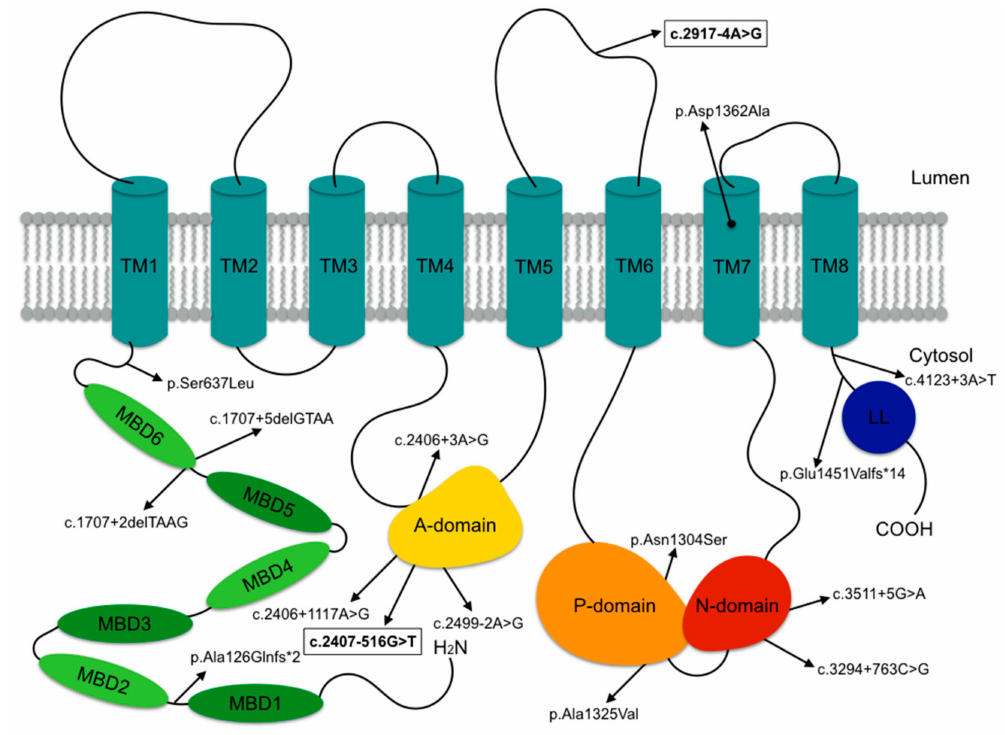
Figure 3. ATP7A pathogenic variants reported in this study. ATP7A consists of six amino terminal metal binding domains (MBD1-MBD6), a transmembrane domain containing eight transmembrane helices (TM1-TM8) and an N-, P- and A- soluble catalytic domain. The pathogenic variants identified in subjects F1:II-1 and F2:II-1 are indicated in bold and